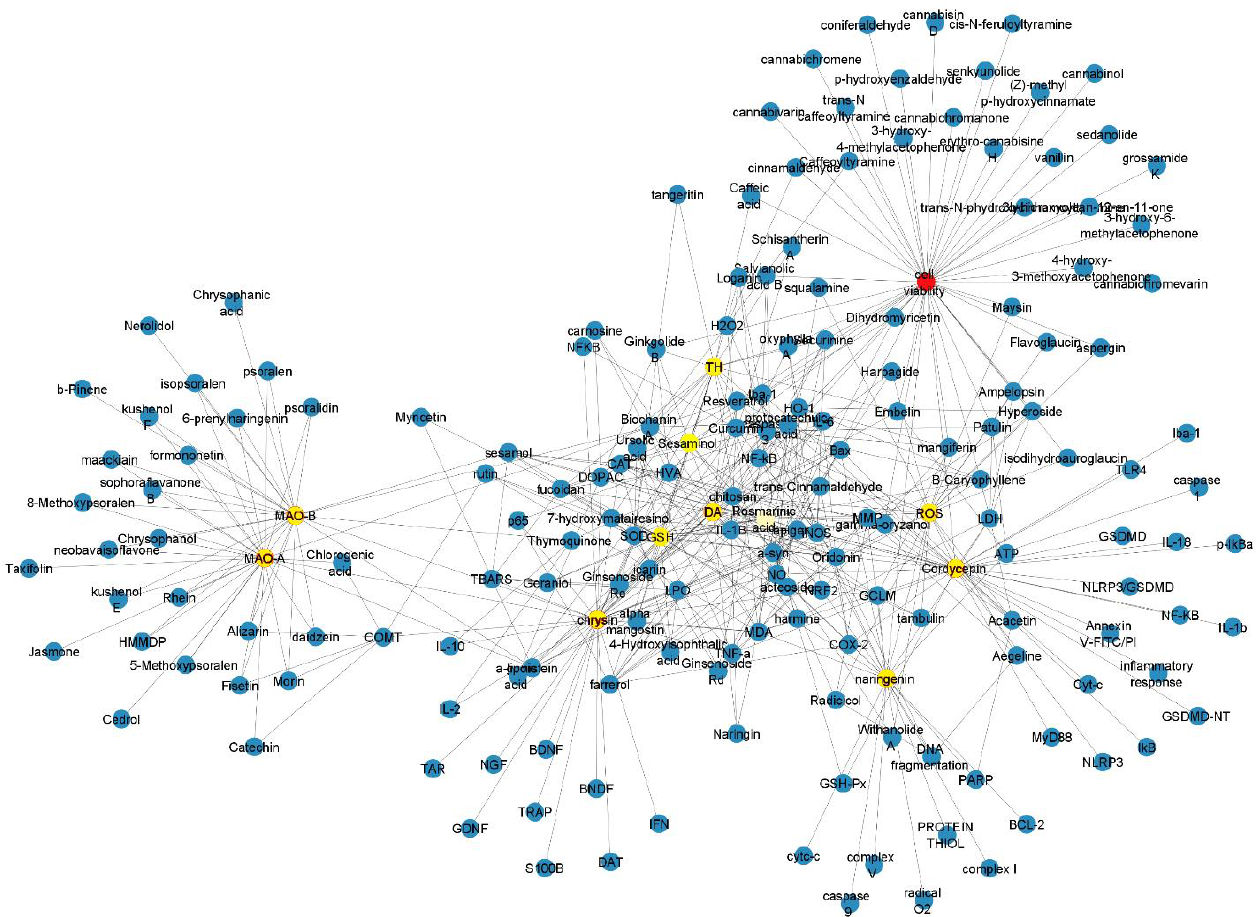
Figure 1. Structural network of the drugs used for Parkinson’s disease treatment, their pharmaco- logical targets, and their representative components. The structural network shows the compounds (yellow nodes) and their pharmacological targets (blue nodes). Nodes represent the compounds and pharmacological targets, and edges indicate the reported interactions among them.